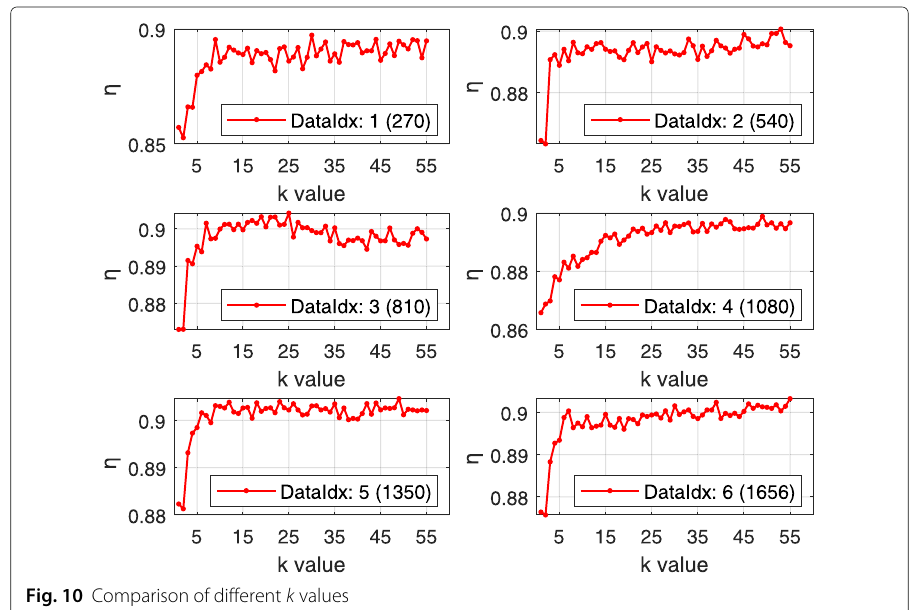
Fig. 10 Comparison of different k values